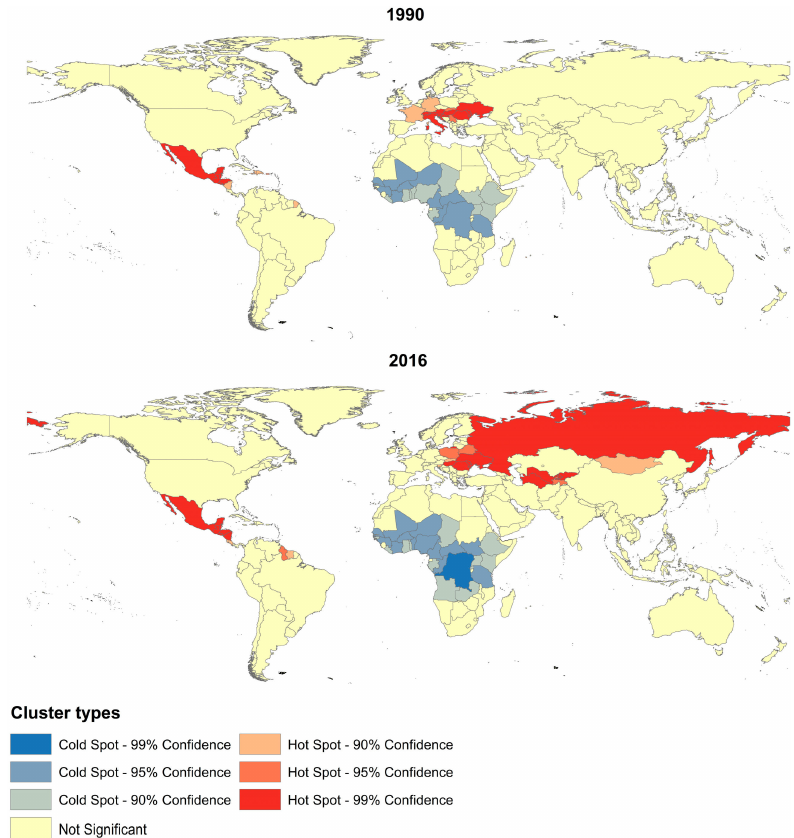
Figure 7. Local spatial autocorrelation for IDU-attributable cirrhosis mortality among 195 countries,